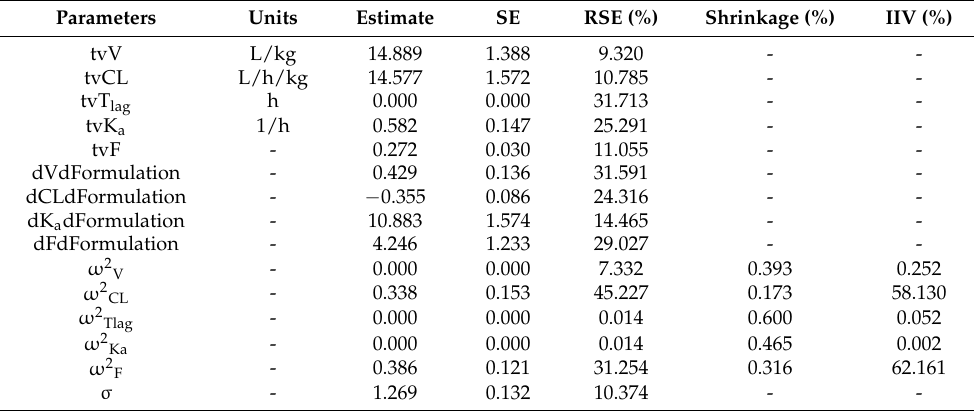
Table 3. Estimated population pharmacokinetic parameters for free methotrexate solution and methotrexate-loaded nanoformulation in the final